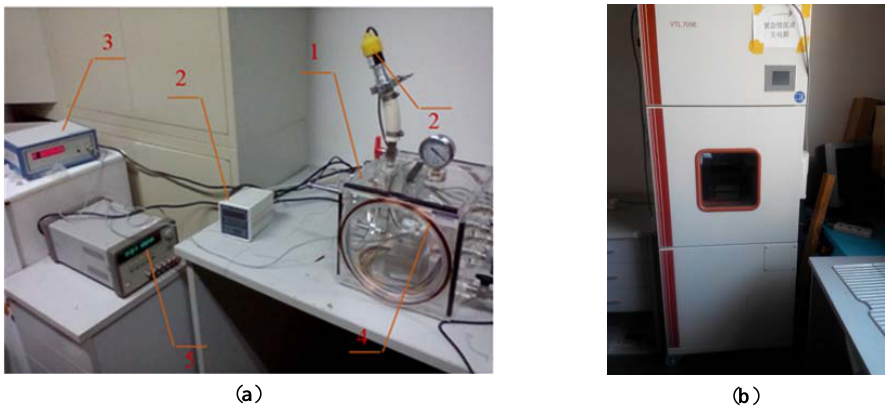
Figure 5. Magnetometer testing. ( a ) Test platform: (1) PMMA vacuum chamber; (2) vacuometer; (3) magnetometer; (4) Helmholtz coil; (5) power source; ( b ) Temperature and climatic chamber for the temperature experiment.